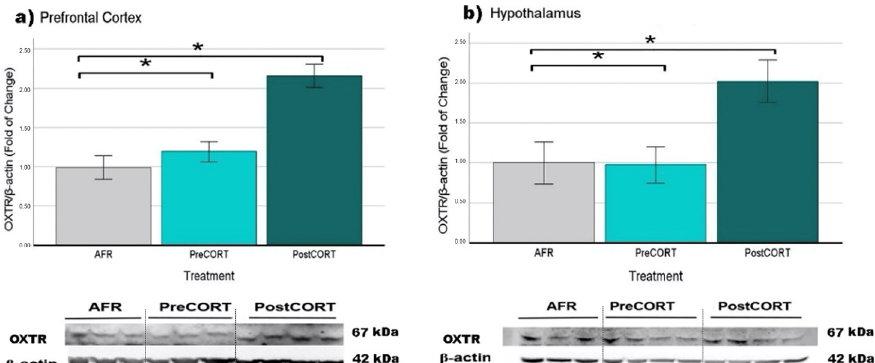
Figure 17. Oxytocin Receptors (OXTR) expression. Histograms and representative bands of OXTR expression in ( a ) prefrontal cortex and ( b ) hypothalamus in AFR ( n = 5, prefrontal cortex; n = 6, hypothalamus); PreCORT ( n = 6, prefrontal cortex; n = 8, hypothalamus) and PostCORT subjects ( n = 5, prefrontal cortex; n = 6, hypothalamus). Each lane corresponds to different mice. Data are presented as mean ± SEM (* p < 0.05).